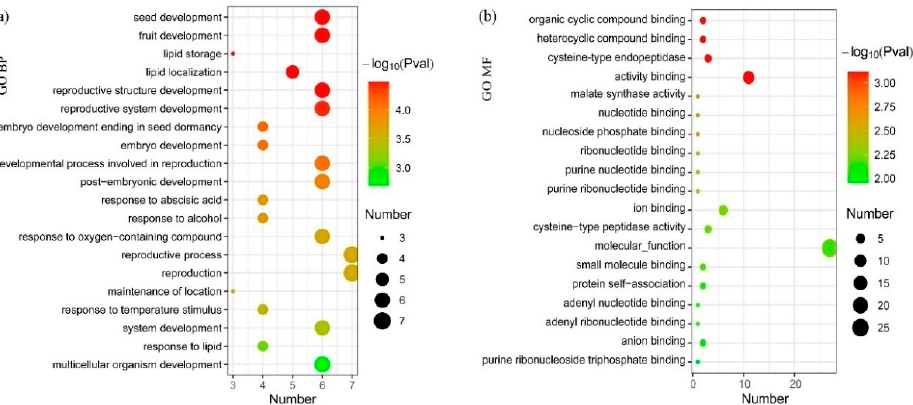
Figure 4. GO enrichment analysis of DNB genes. ( a ) In the results of the GO analysis, ‘seed development’, ‘fruit development’ and ‘lipid storage’ were the top GO terms. ( b ) ‘Organic cyclic compound binding’, ‘heterocyclic compound binding’, and ‘cysteine-type endopeptidase activity’ were significantly enriched in the molecular functional category.